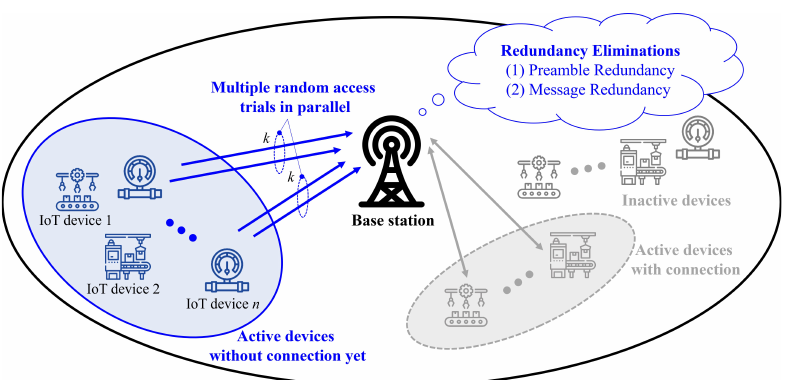
Figure 1. System model: A number of IoT devices are attempting connection establishment with the BS. Note that inactive IoT devices and active IoT devices already have connection with the BS are out of interest in our system